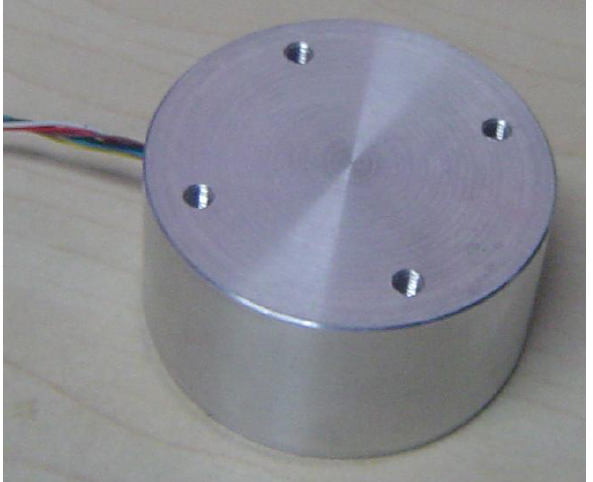
Figure 8. The appearance of a new digital angular rate sensor.